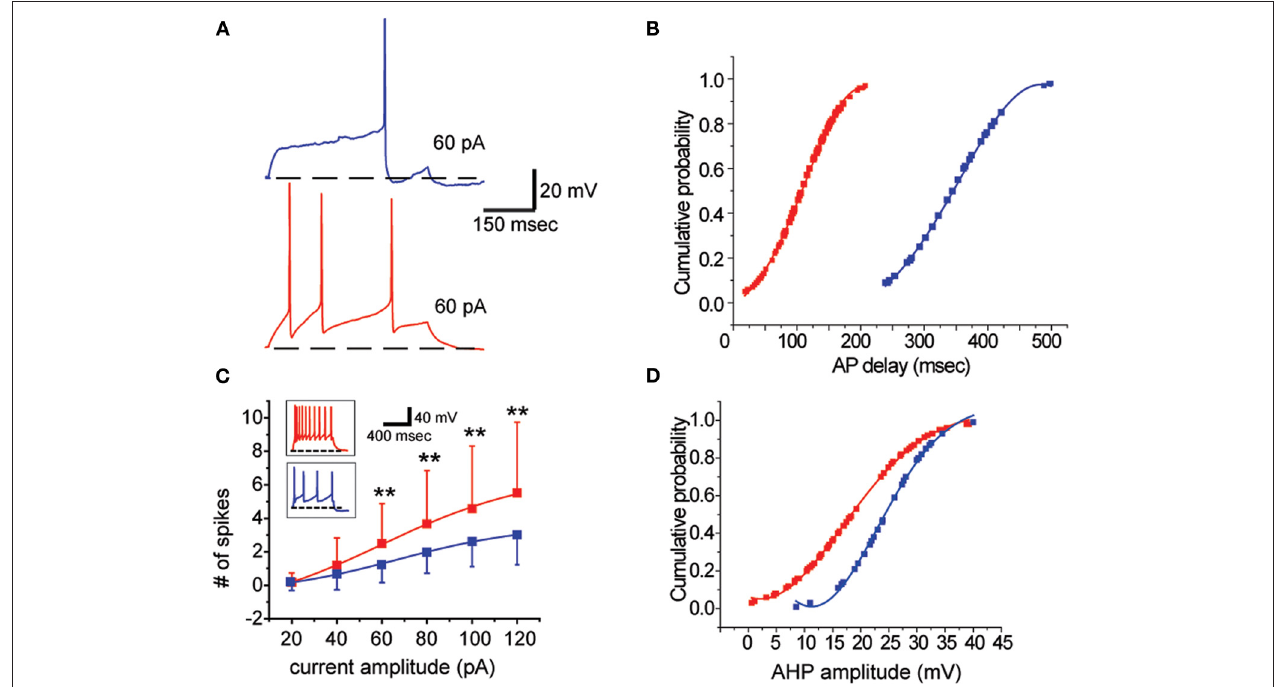
distinguishable groups. (C) Scatter plot illustrating the current-frequency (I-F) curve of LF (blue) and EF neurons (red). Insets are representative examples of firing behavior in response to 120pA current injections from − 70mV. Dashed lines correspond to − 70mV and the scale bar applies to both insets. (D) AHP amplitude distributions for LF (blue) and EF neurons (red). Despite some overlap, LF neurons had higher amplitude AHPs.